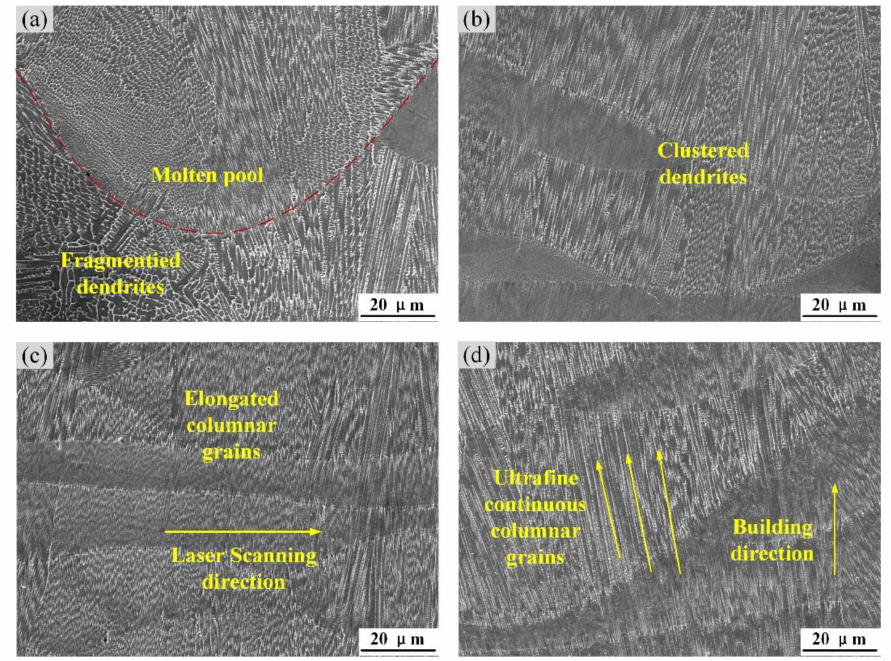
Figure 5. SEM micrographs of LPBF-manufactured K418 samples at various energy densities VED : ( a ) 37.5 J/mm 3 ; ( b ) 62.5 J/mm 3 ; ( c ) 81.6 J/mm 3 ; ( d ) 93.7 J/mm 3